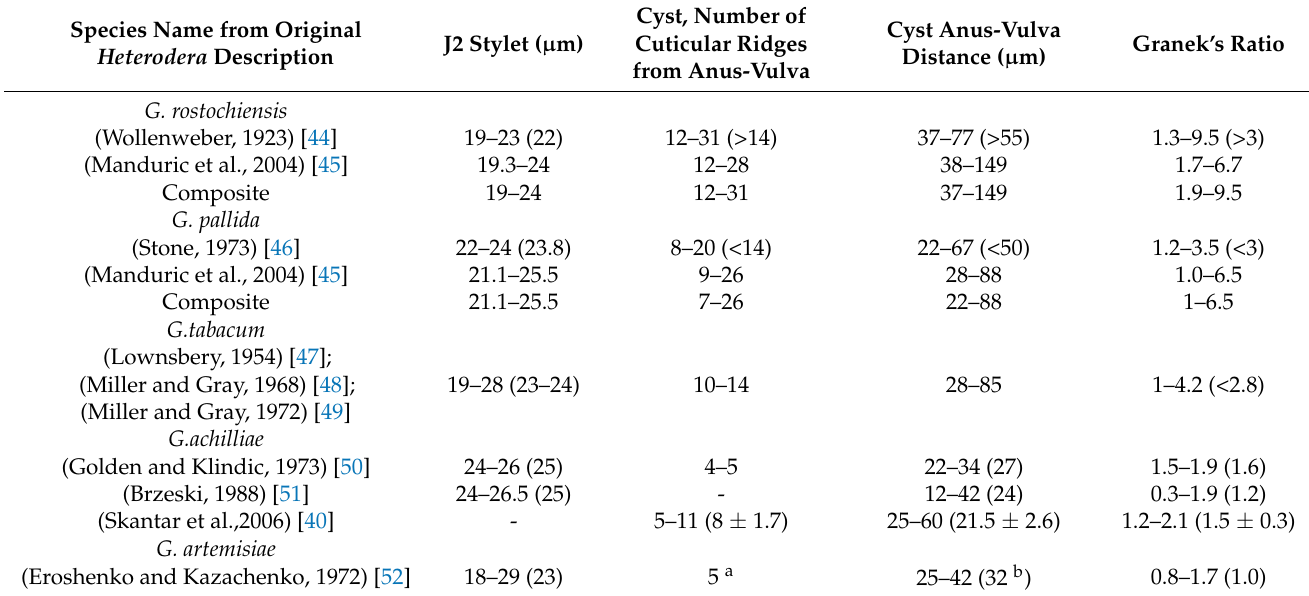
Table 4. Morphometrics for Globodera Behrens, 1975 after Skantar et al. [40] (courtesy of Journal of